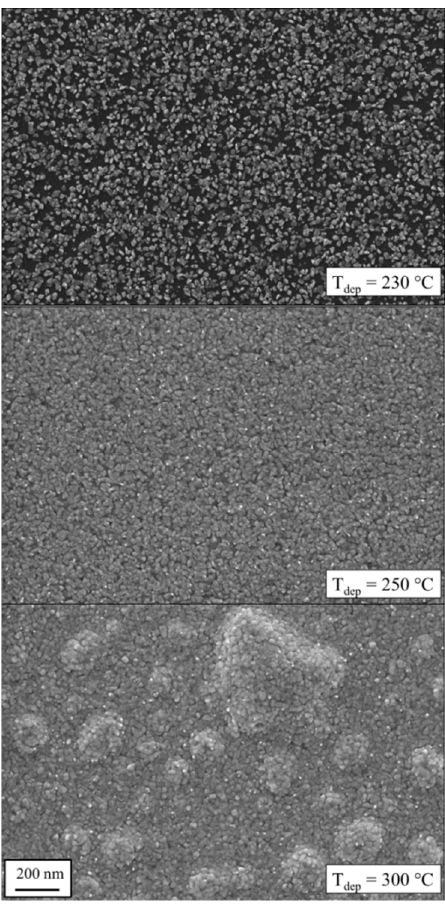
Figure 3. Scanning electron microscopy (SEM) images of Ru layers at different deposition temperatures after 500 ALD cycles. While no deposition was observed below T dep = 200 °C, blistering after 500 ALD cycles. While no deposition was observed below T dep = 200 ◦ C, blistering occurred at occurred at higher temperatures. A temperature optimum was found at 250 °C. higher temperatures. A temperature optimum was found at 250 ◦